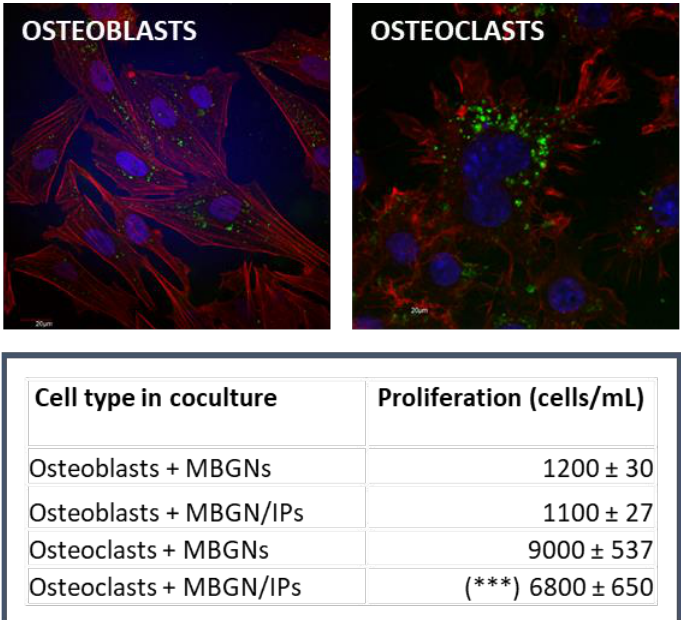
Figure 4. Incorporation of MBGNs labelled with FITC by osteoblasts/osteoclasts after 7 days in coculture and effects of MBGNs and MBGN/IPs on the proliferation of each cell type. Confocal images show the intracellular FITC-MBGNs in green, the actin cytoskeleton in red, and the nuclei in blue. Statistical significance: *** p < 0.005, comparison between osteoclasts treated with MBGNs and MBGN/IPs.